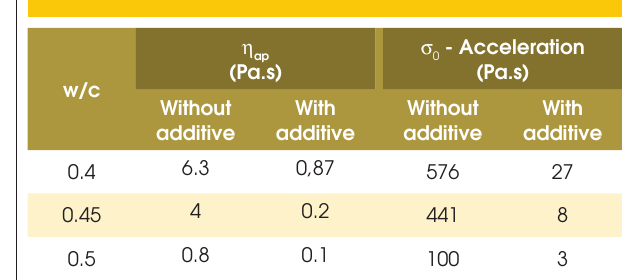
Table 3 – Rheological properties of cement pastes after hydration of 20 min